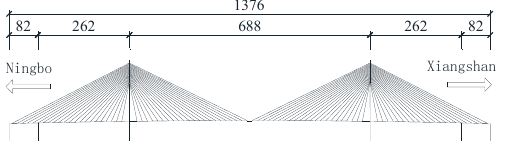
Figure 4. Layout of main bridge (m).